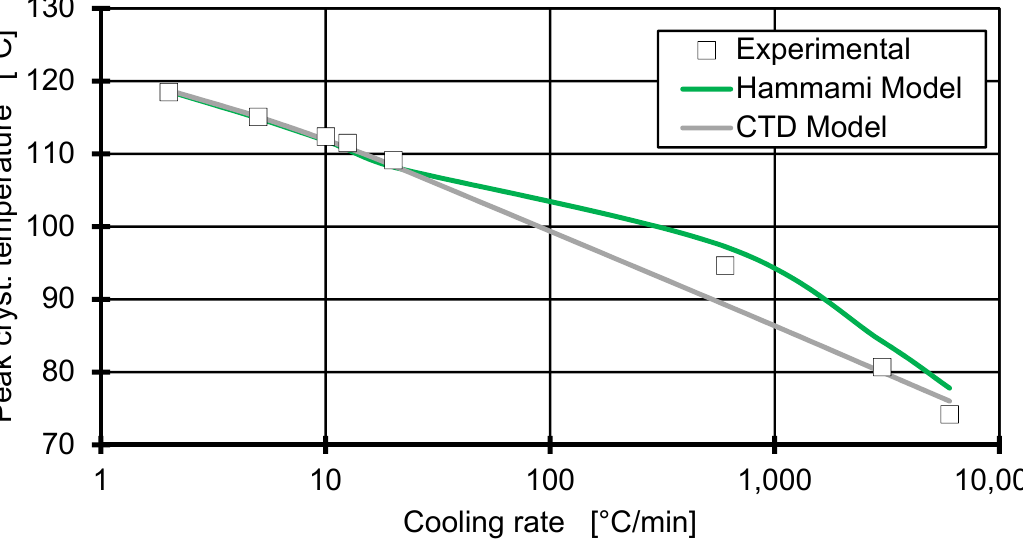
Figure 8. Comparison between the prediction of the peak crystallisation temperature by the Hammami model and the continuous two-domain pvT model (CDT). The markers show the measured peak crystallisation temperatures from the DSC and Flash DSC experimental data.